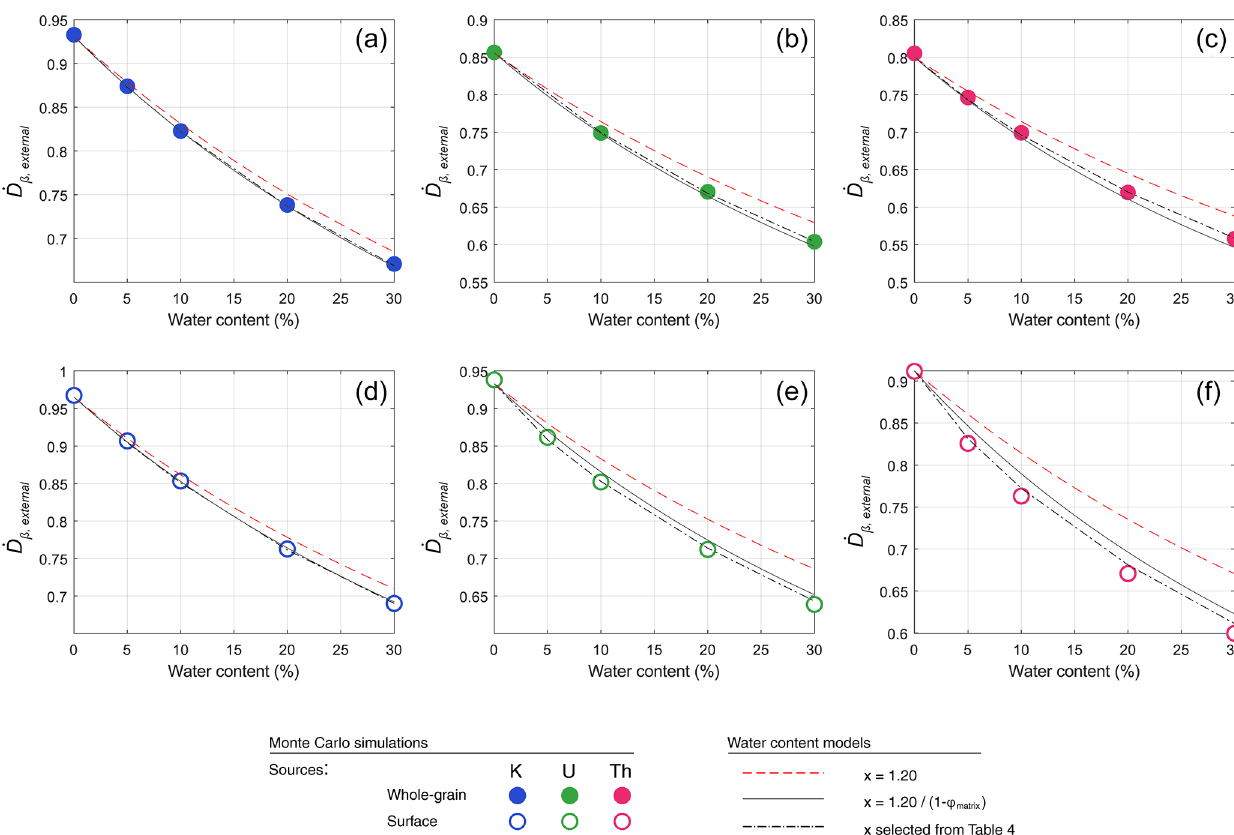
Figure 4. Simulated beta dose to 200µm grains in a sandy matrix (mean grain size 250µm) plotted against the water content. Simulations are shown for K, U, and Th sources, either whole-grain or surface-held sources. The external beta dose is expressed as a fraction of the IM beta dose rate. Also shown are predicted dose rates using three different derivations for x